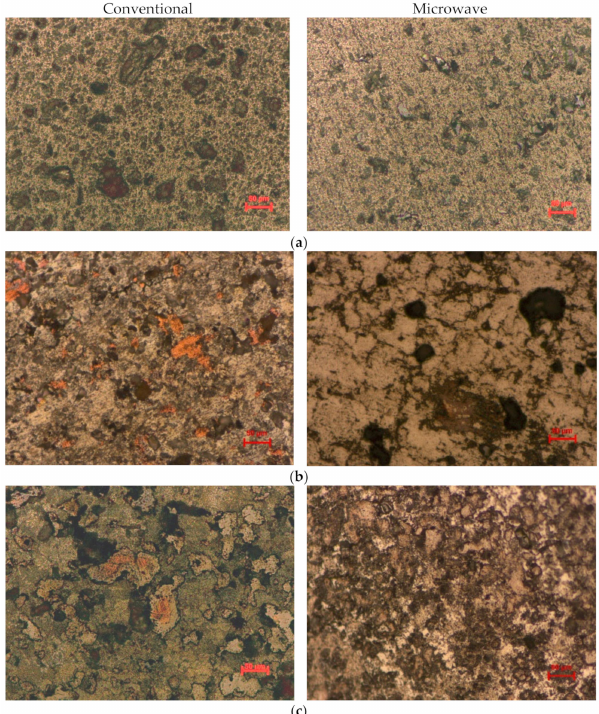
Figure 2. Optical microstructure of etched aluminum compacts of ( a ) Al-22.5%Mn; ( b ) Al- 18.6%Cu-24.12%Mn; ( c ) Al-20%Cu-15%Mn sintered in conventional furnace (left) and microwave furnace (right). Table 5. Weight percentages of elements resulted from EDS analysis of particulate compacts of Al-alloys sintered in conventional and microwave furnaces.